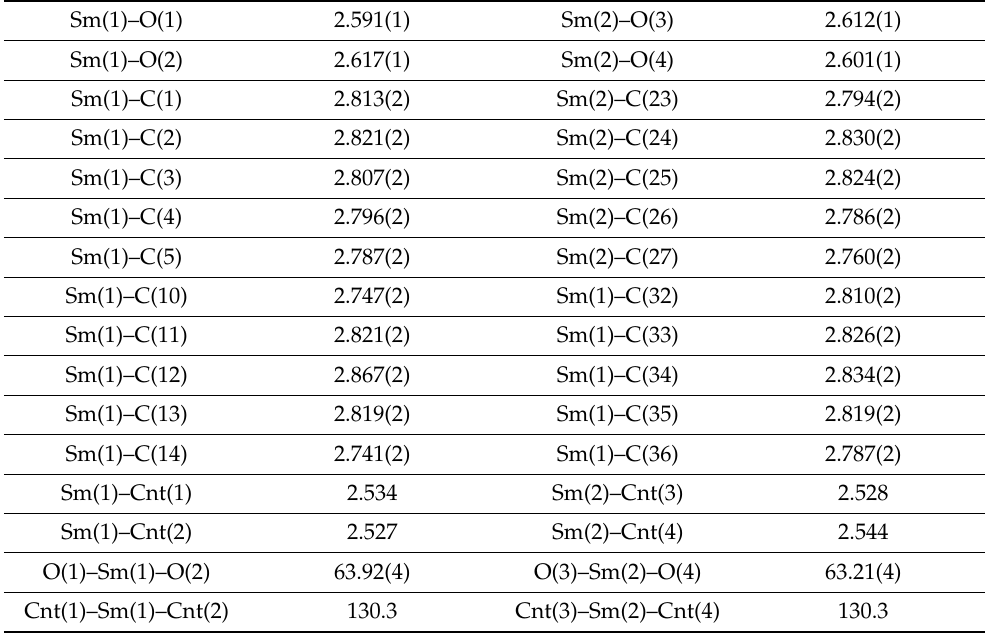
Table 1. Selected bond distances (Å) and angles (°) for (C 5 Me 4 H) 2 Sm(DME), 2 .